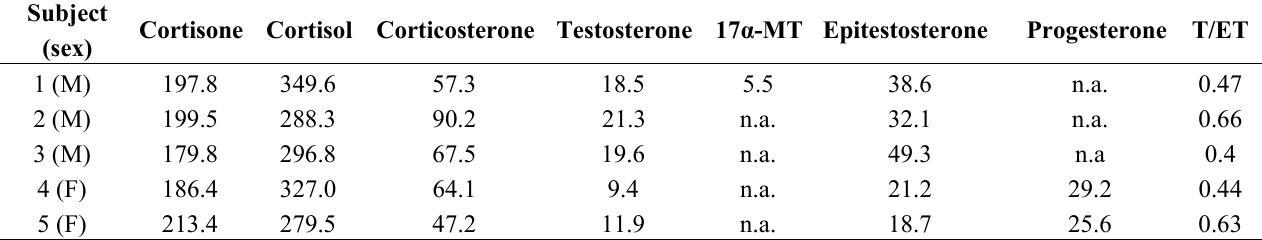
Table 6. Steroid hormone concentrations (in ng mL − 1 ) designated in urine samples from healthy volunteers